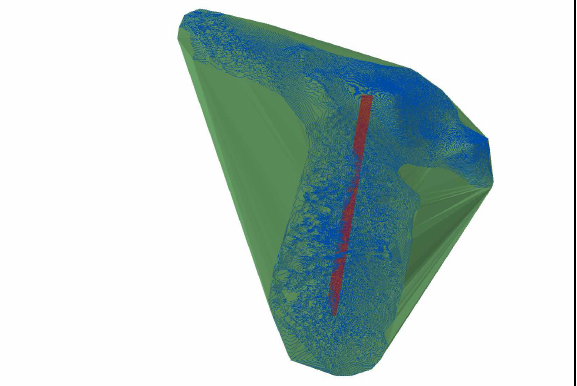
Figure 7. Main runway hypothetical position